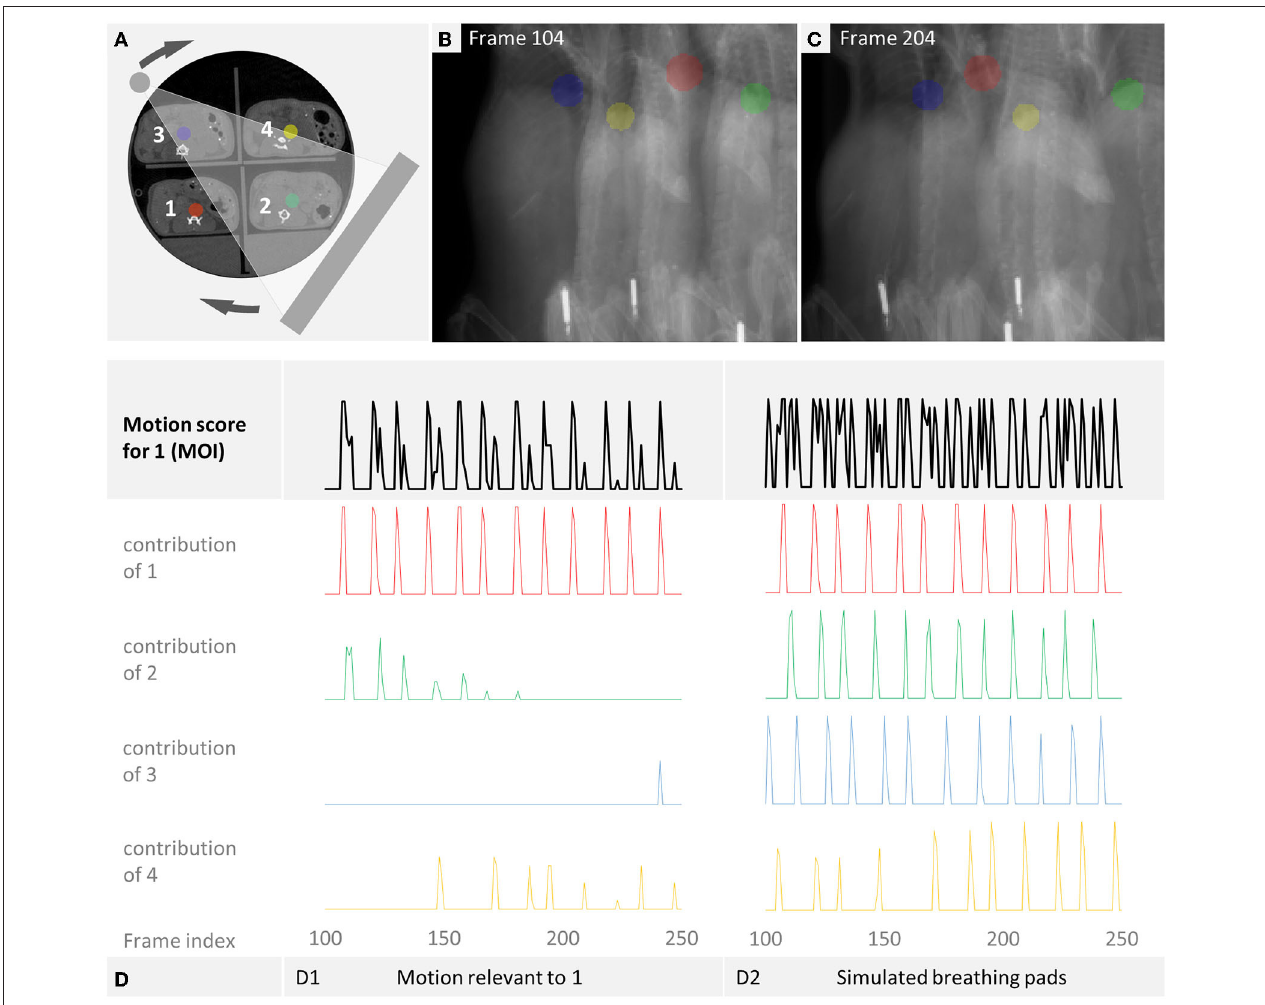
FIGURE 4 | Overlap of respiratory motion. We determined the motion score for mouse 1 (MOI). All curves are derived from the manual breathing examination of all projections. (A) The x-ray source and detector rotate around the sampled multi-mouse bed. (B,C) Show the different resulting projections. (D1) Shows the motion score for a simulated 4-mice-scan with overlap-based projection rejection that results when only those respiratory motions are considered which overlap the MOI. (D2) Simulates a 4-mice scan with breathing pads. Lacking the information, in which mice overlap in which projection, every respiratory motion needs to be considered. The resulting cumulative curve of the motion score shows irrelevant contribution of other mice leading to unnecessary projection